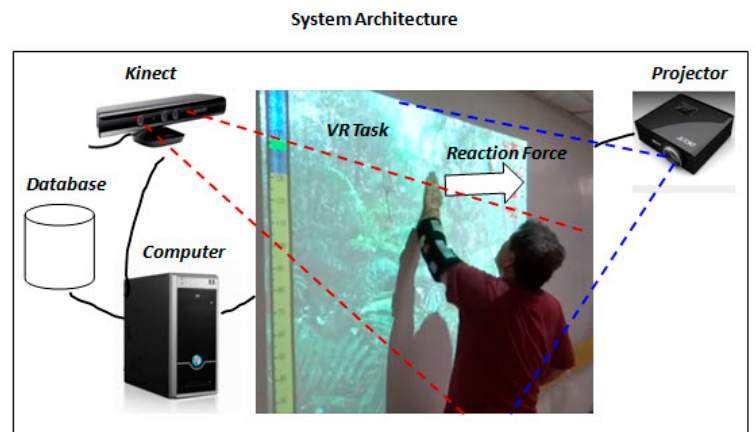
Figure 1. The diagram of the system architecture.